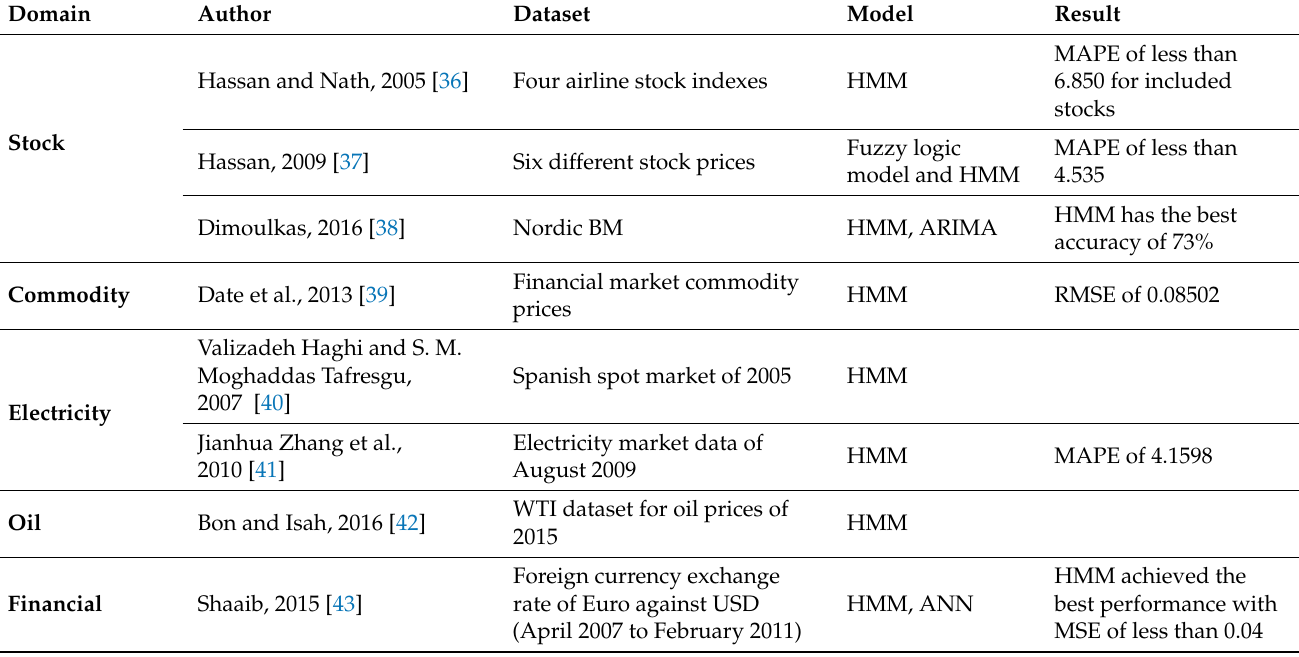
Table 4. HMM time-series forecasting from 2007 to